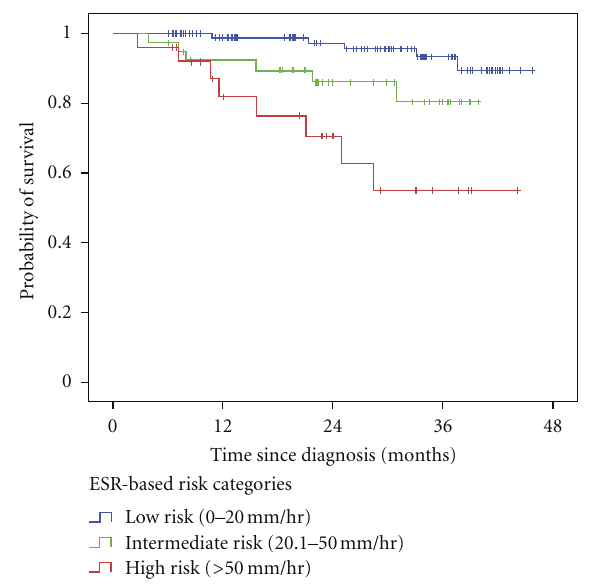
Figure 1: Kaplan-Meier survival analysis of probability of survival versus time since surgery (days) by preoperative ESR Risk Category among patients diagnosed with localized clear cell RCC undergoing potentially curative nephrectomy. Patients categorized into Low Risk ( ≤ 20.0mm/hr), Intermediate Risk (20.1–50.0 mm/hr), and High Risk ( > 50.0mm/hr) based on preoperative ESR levels. Log- rank: Low Risk versus High Risk ( P < 0 . 001), Low Risk versus Intermediate Risk ( P = 0 . 033), Intermediate Risk versus High Risk ( P = 0 .